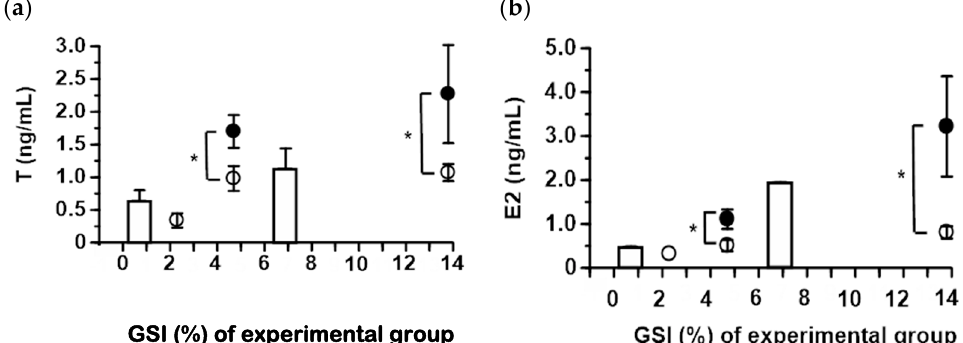
Figure 2. Serum levels of testosterone, T, ( a ) and estradiol-17 β , E2, ( b ) in artificially maturing female Japanese eels (circles) and in wild-caught female longfin eels (white columns) during vitellogenesis. Steroid levels in Japanese eels were determined just prior to (open circles) or 2 days after (black circles) exogenous hormone treatment. Stages of ovarian development are as in Figure 1. Values represent mean ± SEM. * P < 0.05 within the same developmental stage.